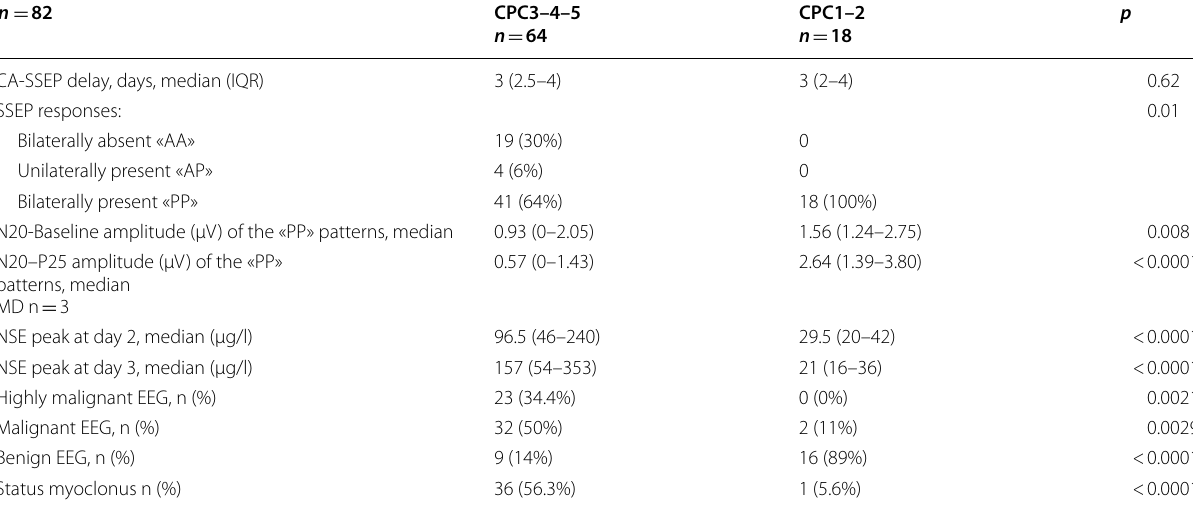
Table 2 Prognostic elements stratified for outcome within 3 months